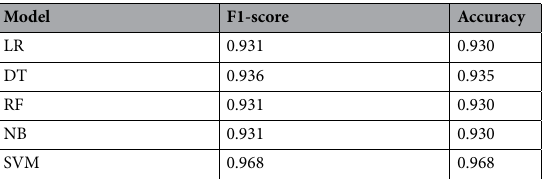
Table 8. Classification with leave-one-out cross validation on the problem of predicting severe disease (ICU admission or death), on the first wave dataset, with previously selected clinical variables. Each row corresponds to a different model